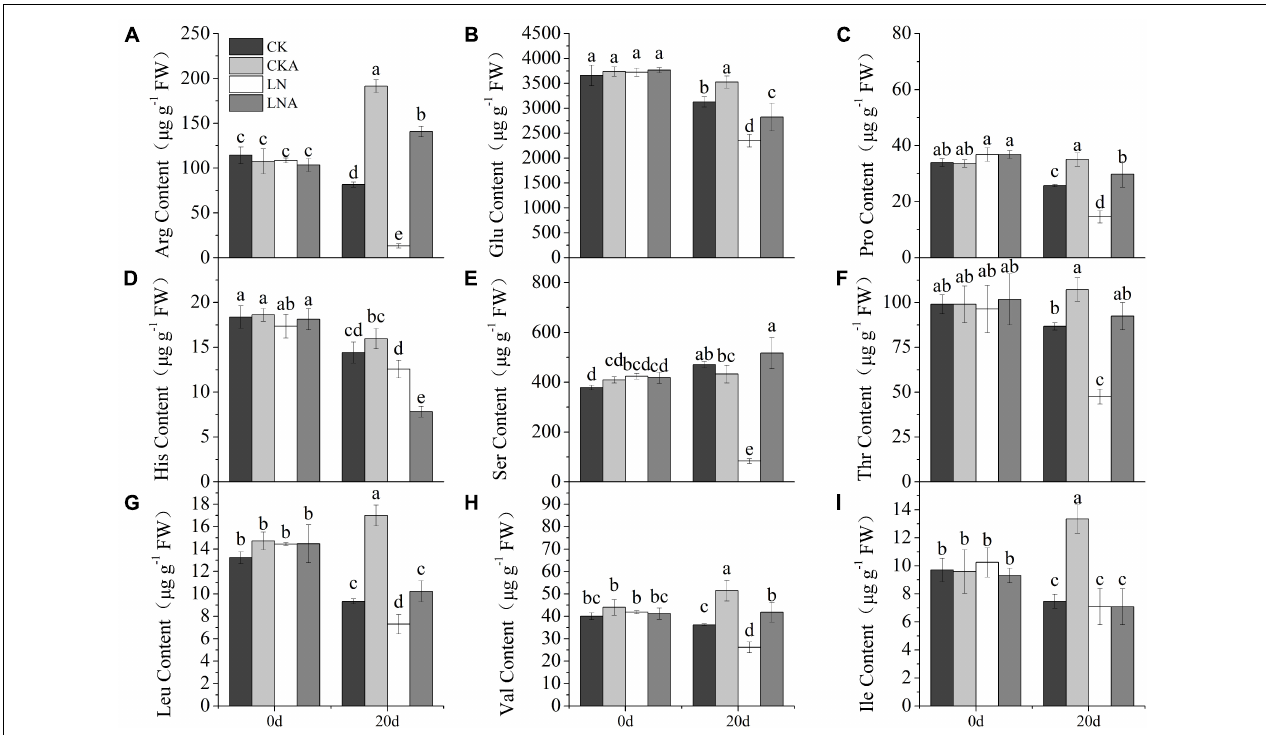
FIGURE 10 | The content of amino acids. Arginine (A) , glutamic acid (B) , proline (C) , histidine (D) , serine (E) , threonine (F) , leucine (G) , valine (H) , and L-isoleucine (I) in CK, CKA, LN, and LNA on the 20th day of treatment. Values are means of five replicates ± SD. Values not represented by the same letter are significantly different according to Tukey’s multiple-range test ( P <